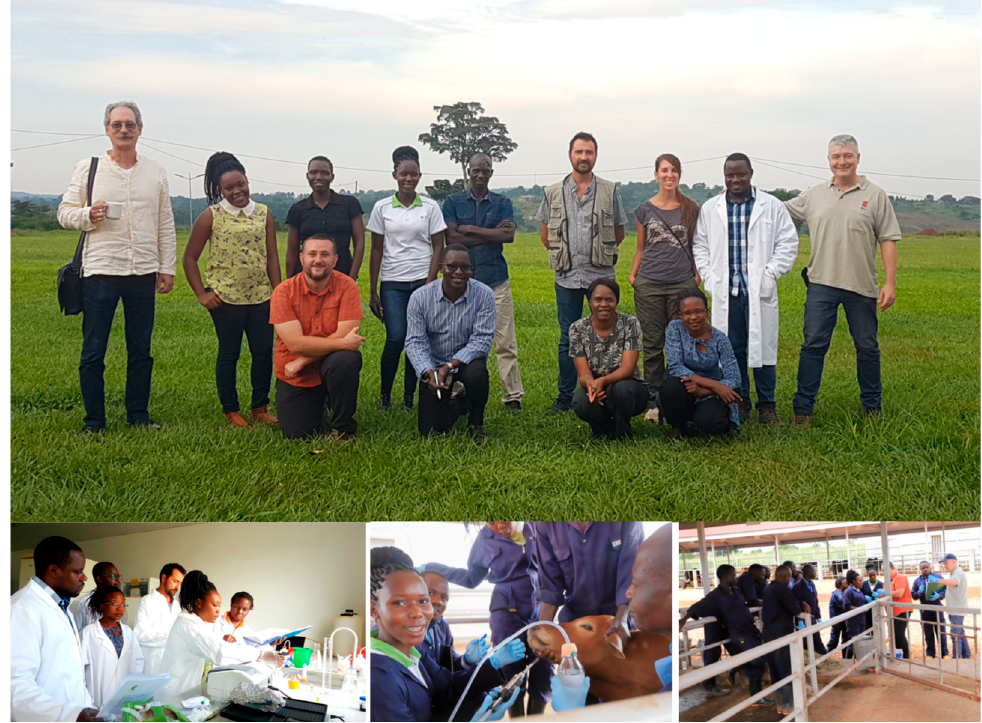
Figure 2. The participants in the course held at NaLIRRI in Wakiso District, Uganda on September 2–